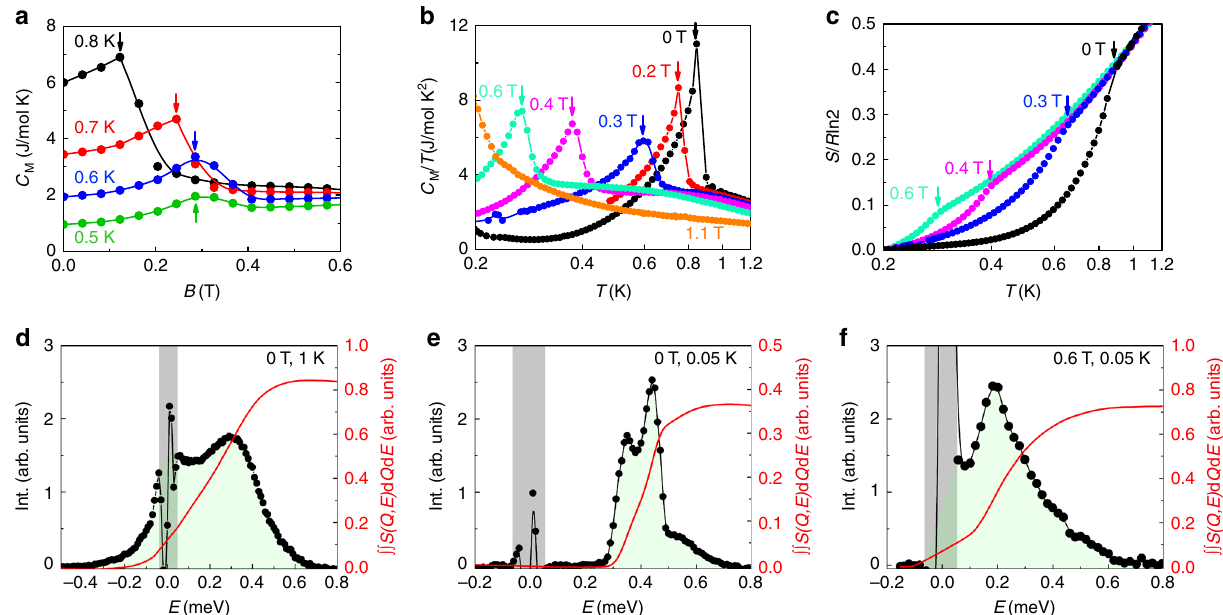
Fig. 5 Fluctuating moments in fi elds. a Field-dependent magnetic speci fi c heat C M / T at different temperatures, as indicated. b Temperature-dependent magnetic speci fi c heat C M / T in different fi elds. c Temperature-dependent entropy, normalized to R ·ln2, assuming doublet ground states. The arrows indicate the magnetic phase transition. d – f Energy-dependent neutron scattering intensity, integrated over wave vector H = [ − 0.2, 0.2] r.l.u., K = [ − 1, 1] r.l. u., and L = [0, 2] r.l.u., at different temperatures and fi elds, as indicated. The red lines are the integrated intensity over the energy spectrum (green shadow area) up to 0.8 meV. The gray bars indicate the instrumental resolution of about ±0.05